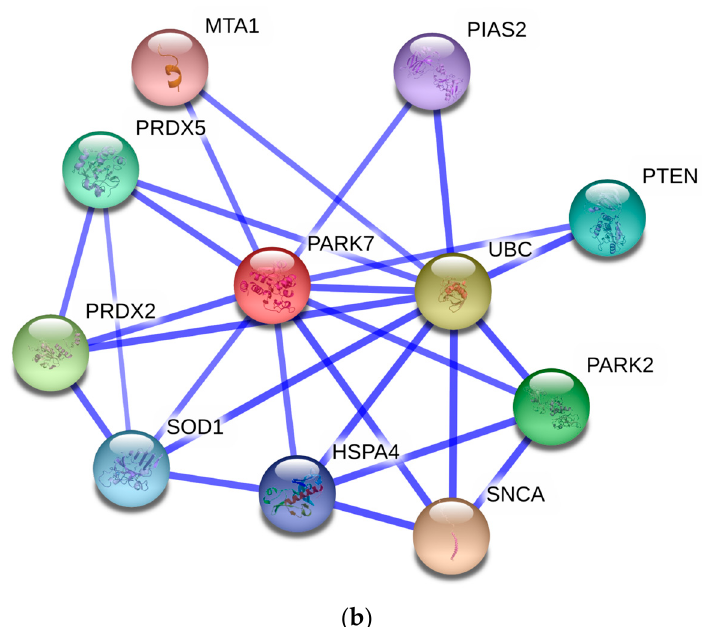
Figure 7. PPI network of ubiquitin B/C and the PARK7 protein: ( a ) the PPI network of ubiquitin B and C proteins; and ( b ) the PPI network of the PARK7 protein.The nodes represent the proteins and the edges represent the corresponding PPI pairs. The thickness of the blue lines represents the confidence score. Required confidence score >0.7.